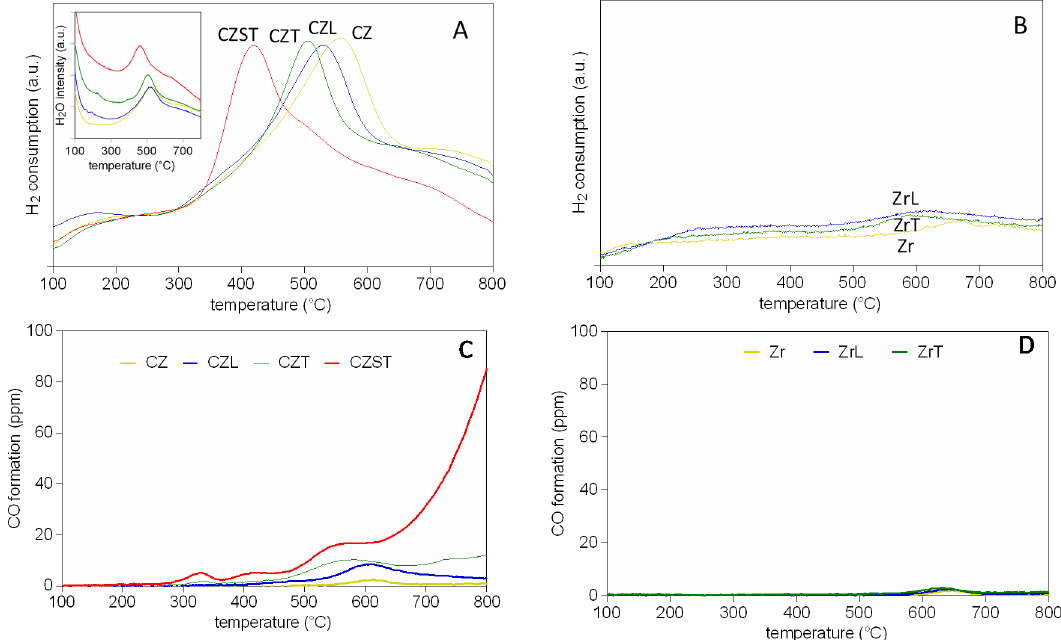
Figure 2. ( A ) H 2 -TPR profile of pure ceria–zirconia (CZ) and CZ/soot mixtures under different contact conditions, ( B ) H 2 -TPR profile of pure zirconia (Zr) and Zr/soot mixtures under different contact conditions; ( C,D ) CO formation from H 2 -TPR followed by FTIR gas analysis. The inset in ( A ) shows H 2 O profiles in temperature-programmed reduction (TPR), followed by mass spectrometry (MS) analysis.